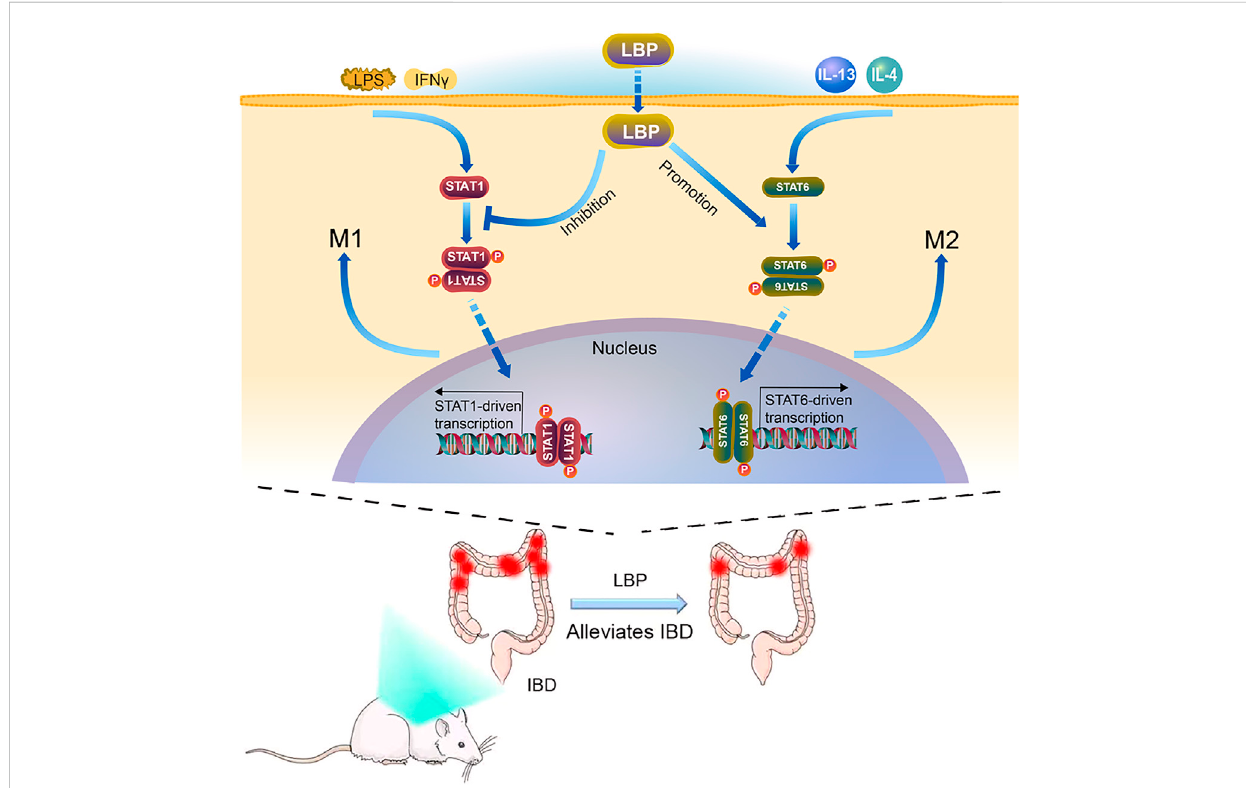
FIGURE 9 The Model diagram of LBP in alleviating IBD by regulating M1/M2 macrophage polarization by STAT1 and STAT6 pathways. In vitro , LBP inhibits the polarization of M1 macrophages by suppressing the phosphorylation of STAT1, and promotes the polarization of M2 macrophages by promoting the phosphorylation of STAT6. In vivo , LBP regulates the polarization of macrophages to protect against DSS-induced IBD by regulating the STAT1 and STAT6